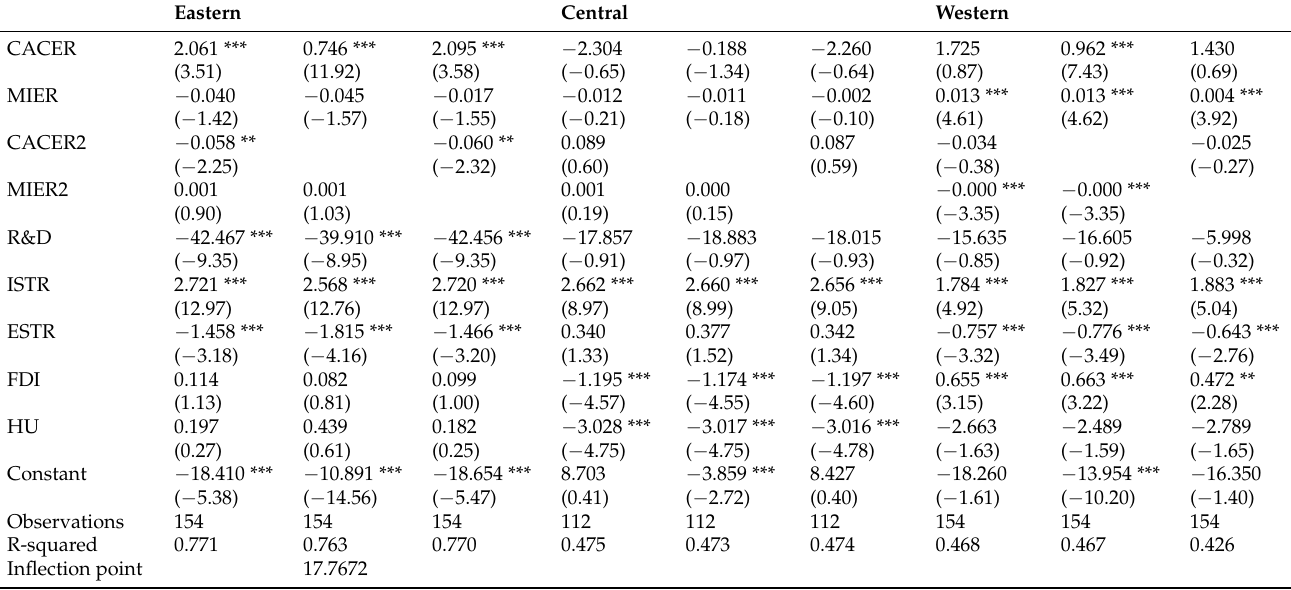
Table A3. The estimated results of the impacts of ERs on OFDI across regions (POOL regression).